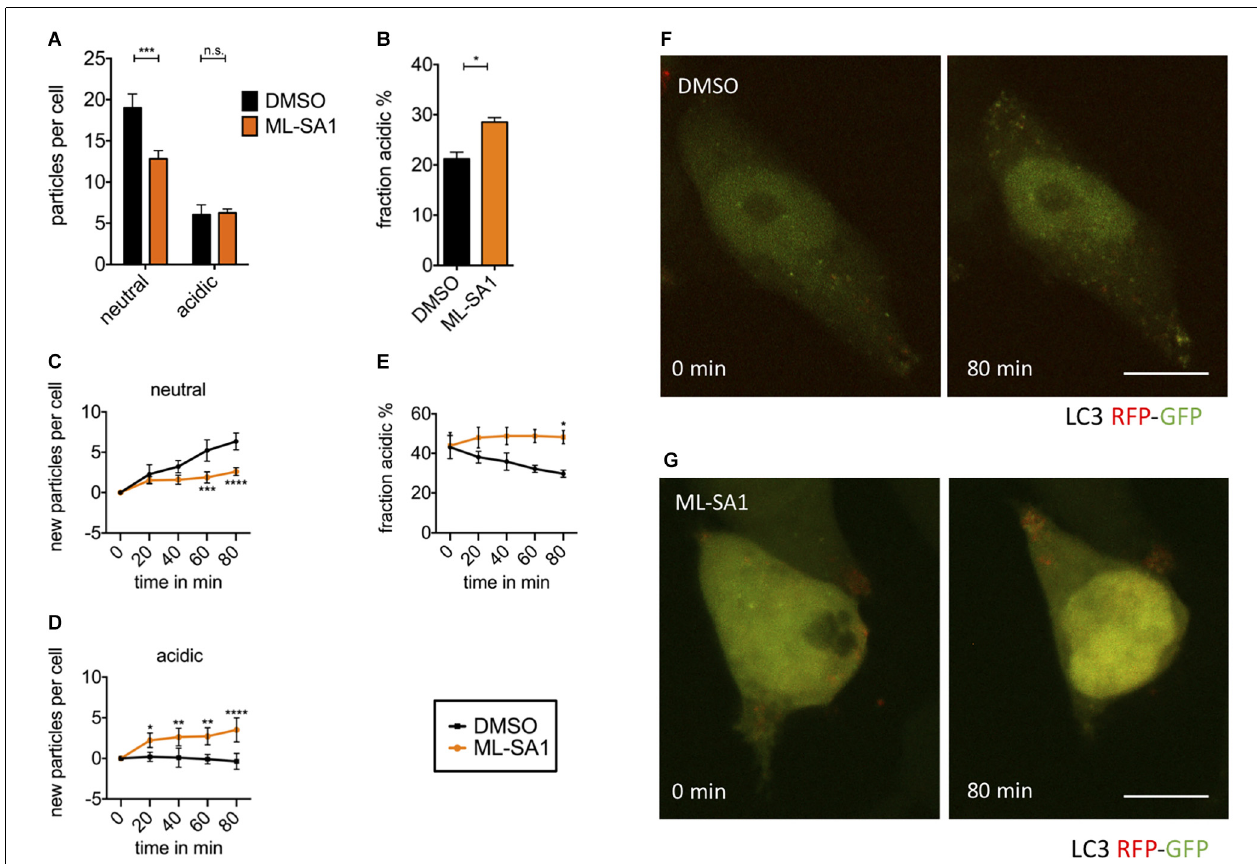
FIGURE 5 | TRPML1- agonist ML-SA1 facilitates autolysosomal maturation. (A) HEK293T cells were transfected with the autophagosome marker LC3 tagged with mRFP-EGFP tandem-fluorescence (TFL) and treated for 18 h either with 25 µ M ML-SA1 or DMSO. The number of neutral and acidic vesicles from n = 3 independent experiments. Two-way ANOVA factors treatment and vesicle type showed significant interaction ( p < 0.0001). Sidak’s multiple comparisons test is depicted with respect to DMSO (control). (B) Fraction of acidic LC3-particles from the experiment described in (A) . Result of unpaired t -test depicted with respect to DMSO ( p = 0.01). (C–F) Time lapse microscopy: HEK293T cells were transfected with the autophagosome marker LC3-TFL. One hour before, the imaging medium was changed to HBSS containing 100 nM BafA1. Immediately before starting imaging, cells were treated with 25 µ M ML-SA1 or DMSO. Imaging was